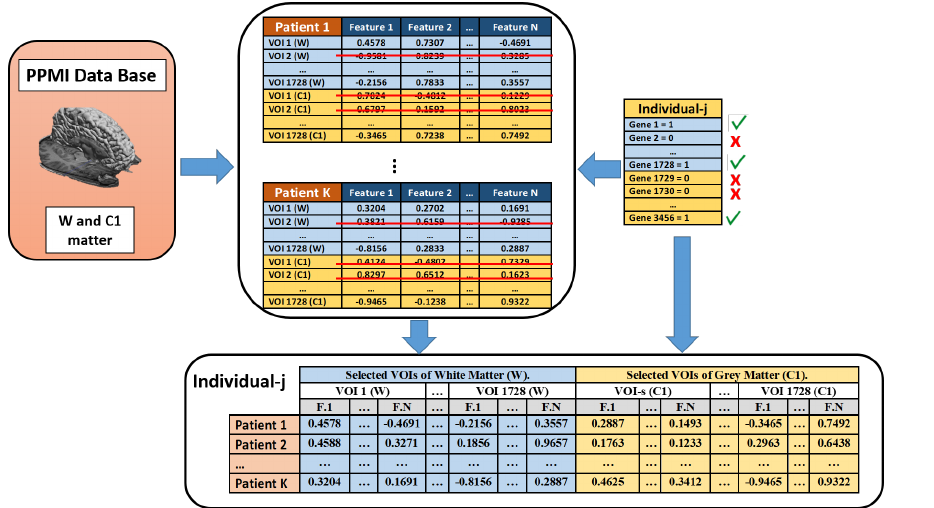
Figure 8. Matrix of coefficients of the 3D-DWT for the different VOIs selected in the individual-j of the Pareto Front.